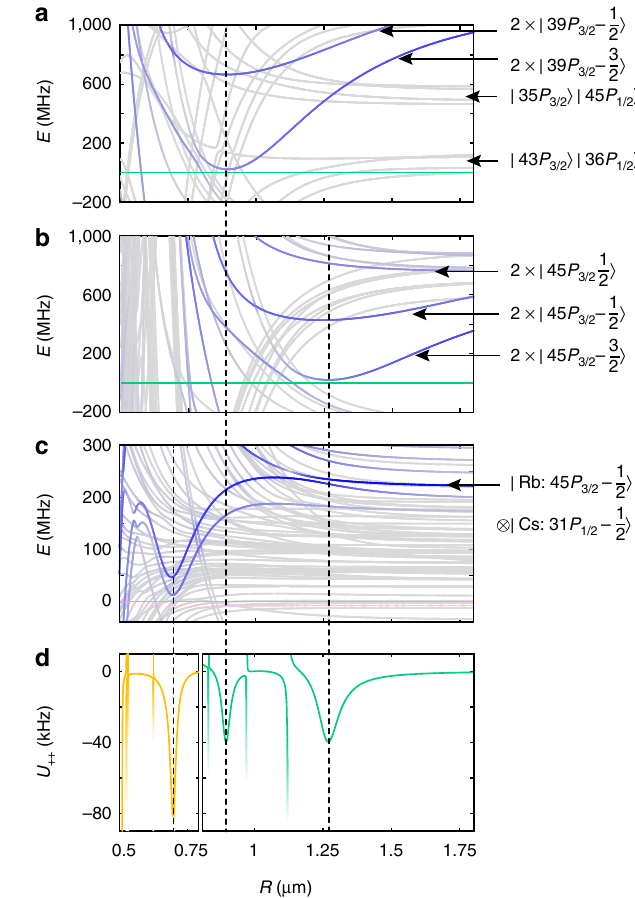
Figure 3 | Enhanced Rydberg dressing. Rydberg-Rydberg interaction energies E around the ( a ) 39 P 3 = 2 ; 39 P 3 = 2 (cid:2) (cid:2) (cid:3) and ( b ) 45 P 3 = 2 ; 45 P 3 = 2 (cid:2) (cid:2) (cid:3) states of 87 Rb and c the mixed 31 P 1 = 2 ; 45 P 3 = 2 (cid:2) (cid:2) (cid:3) Rydberg state of 133 Cs and 87 Rb, in a magnetic field of B z ¼ 26G along the z axis. The intensity of the blue colouring indicates the overlap with the laser-targeted Rydberg states. The most strongly coupled pair potentials feature distinct local minima, which can be exploited in an enhanced Rydberg dressing scheme by detuning the Rydberg dressing laser such that, in the rotating frame, the pair ground state energies (green line for the þ s þ s j i state in a , b , and yellow line for the þ s þ a j i state in ( c ) approach the minima of the potential wells. This configuration leads to relatively large and strongly peaked level shifts of the dressed ground states, as can be seen in d which shows the resulting interaction potential U þþ between two Rydberg- dressed Rb–Cs (yellow) and Rb–Rb (green) ground state atoms. Drastically p p , a L and ffiffiffi 2 a L , thereby enhanced peaked-like interactions appear at a L = ffiffiffi 2 realizing the required plaquette interaction of equation (3) for a ¼ 2 and b ¼ 1. Vertical dashed lines connect the extrema in the ground state level shifts to the corresponding Rydberg potential minima in the excited state manifold. Various resonances due to accidental degeneracies of the ground states with weakly coupled excited states are visible as well, but these are of negligible width and occur away from lattice